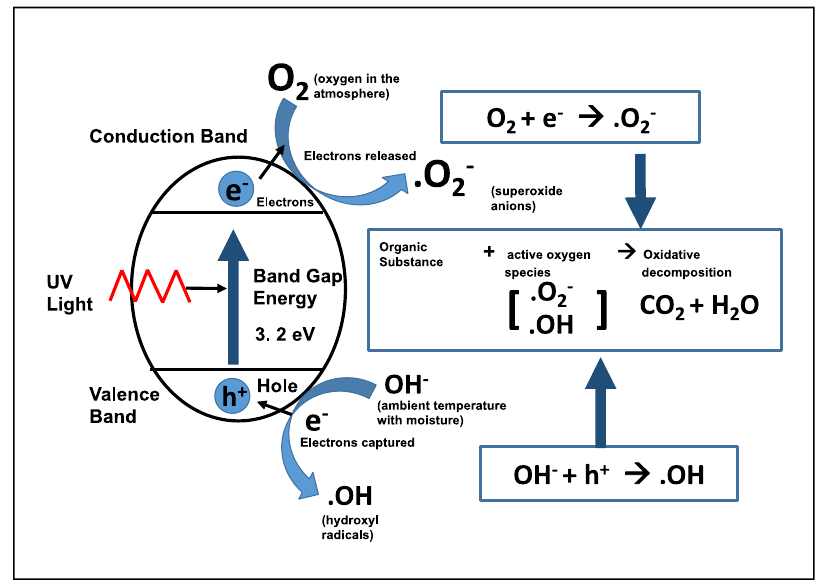
Figure 2. Schematic photoexcitation of an electron on the TiO 2 surface and the creation of holes, which attract water molecules to generate hydroxyl radicals and superoxide ions. (Adapted from [67] ).